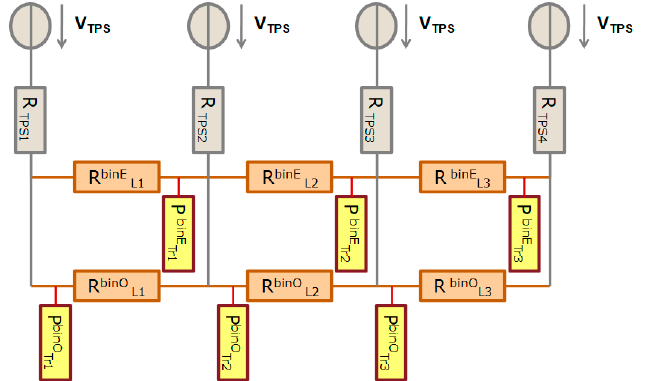
Figure 5. Electric software circuit model.